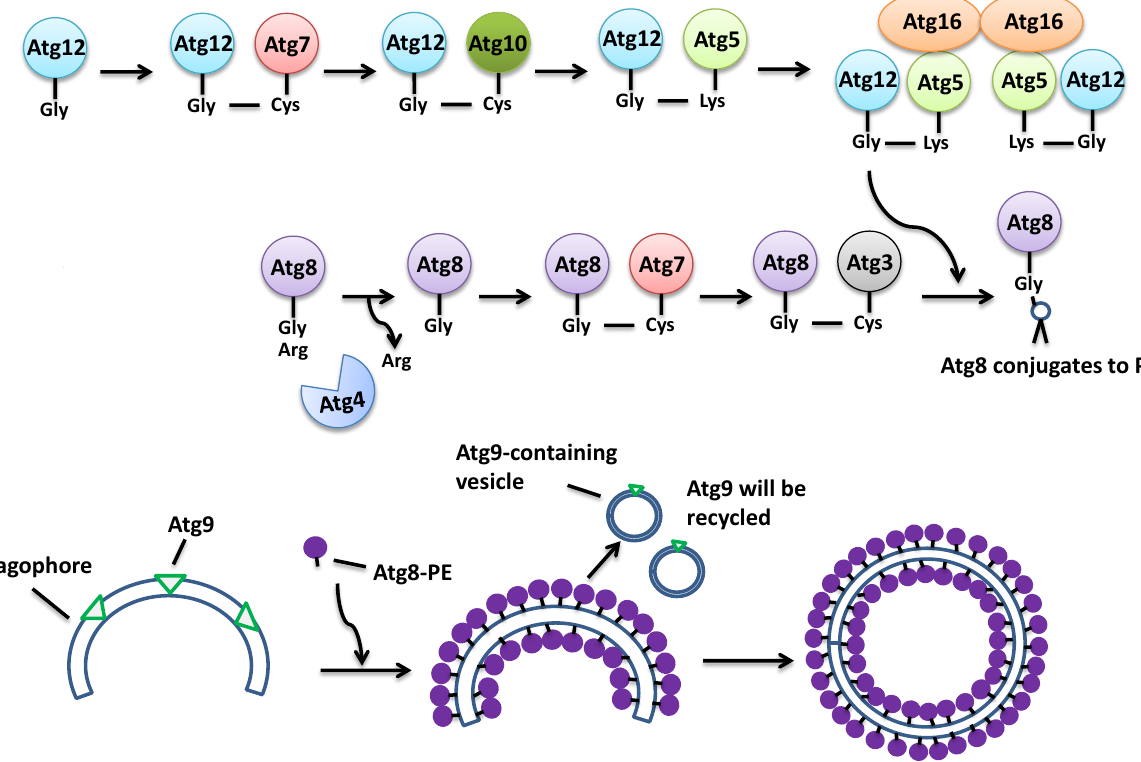
Figure 3. Steps to form the autophagosome. (1) Atg8 binds to PE through two ubiquitin-like pathways; (2) Atg8-PE binds to the phagophore; (3) The phagophore elongates to form the autophagosome. Atg9 recycles back to its original